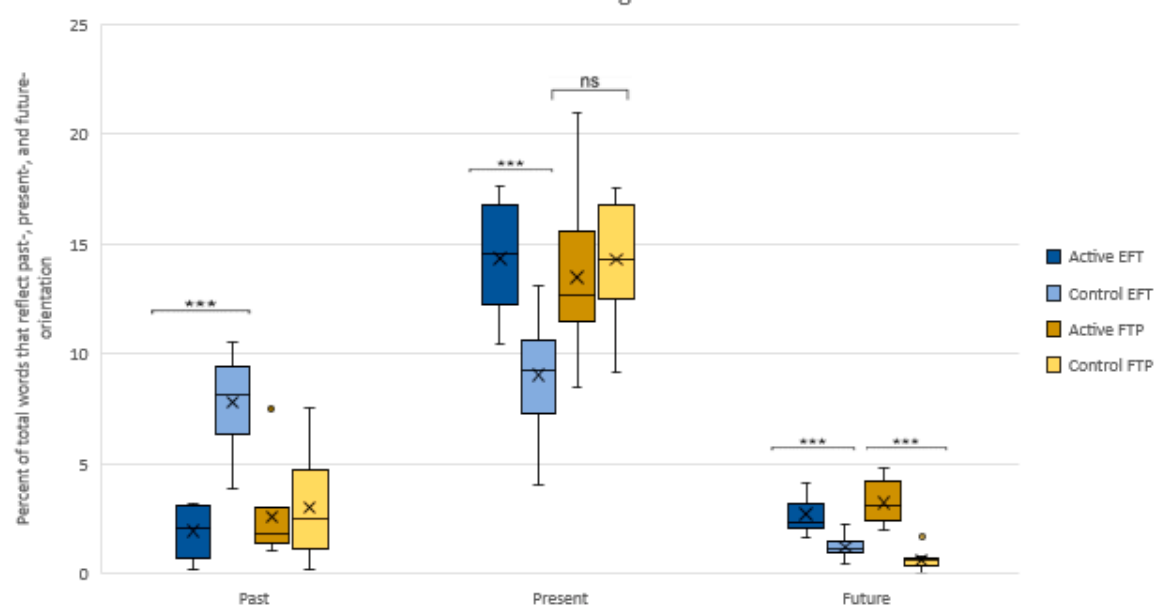
Figure 2. Percentage of total words that reflect past-, present-, and future-oriented text for Episodic Future Thinking and Future Thinking Priming active vs. control conditions. *** = p < 0.001, ns = not significant.